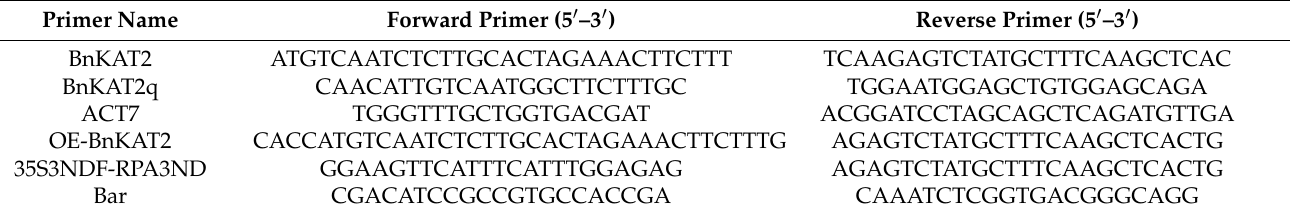
Table 1. Primers used in this